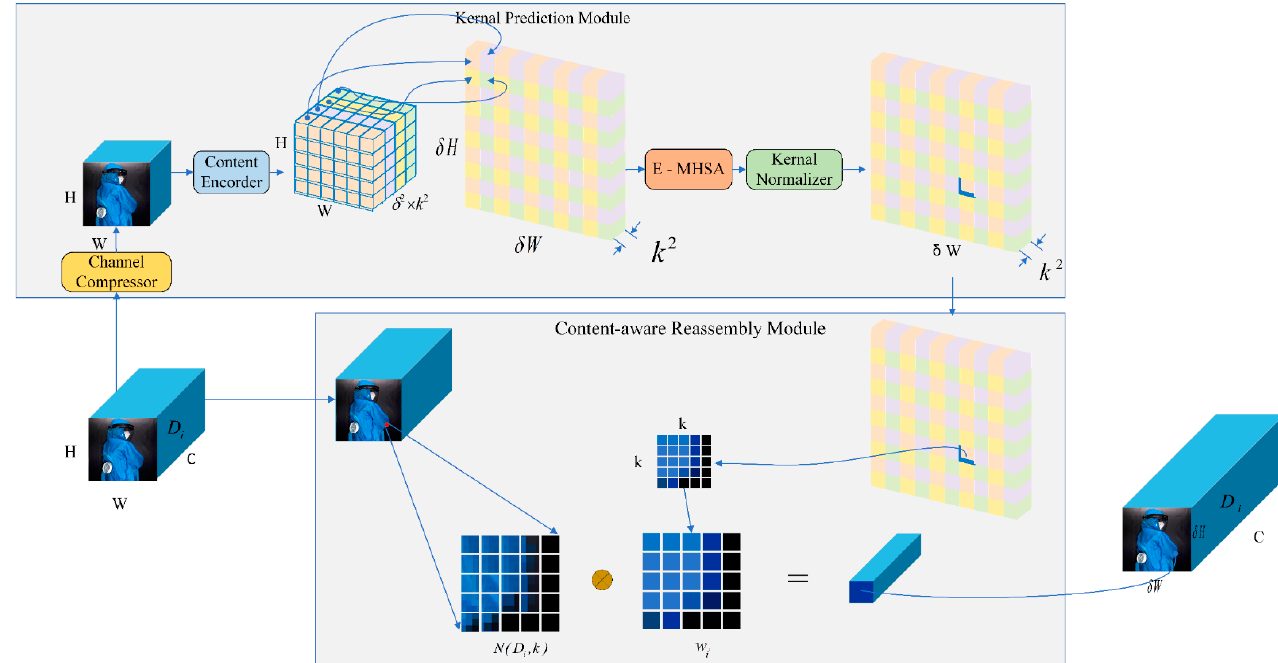
Figure 3. Up ‐ sampling enhancement module (USEM). A feature map with size C × H × W is upsam ‐ Figure 3. Up-sampling enhancement module (USEM). A feature map with size C × H × W is pled by a factor of δ (= 2) in this figure. upsampled by a factor of δ (= 2) in this